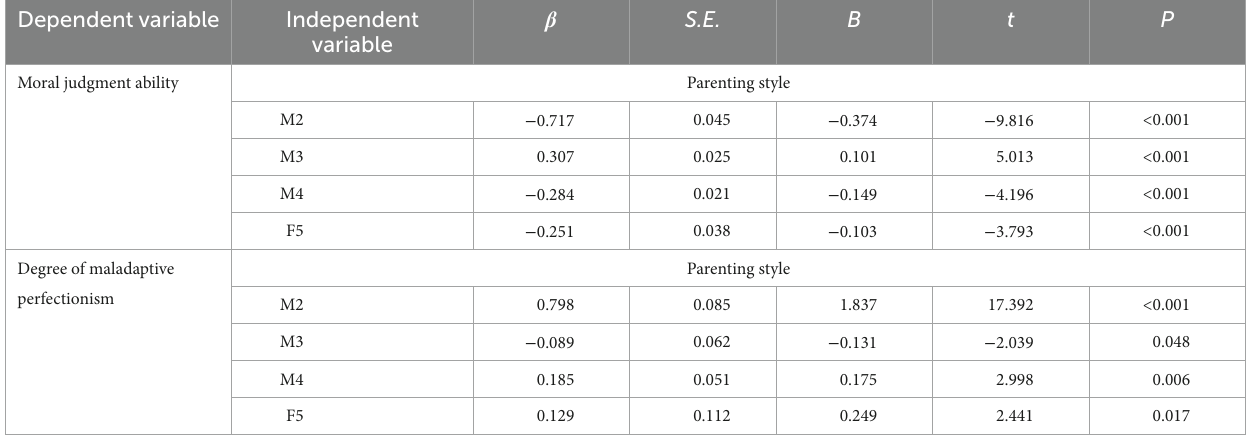
TABLE 5 Multiple linear regression analysis of the influence of parenting style on moral judgment ability and degree of maladaptive perfectionism in patients with